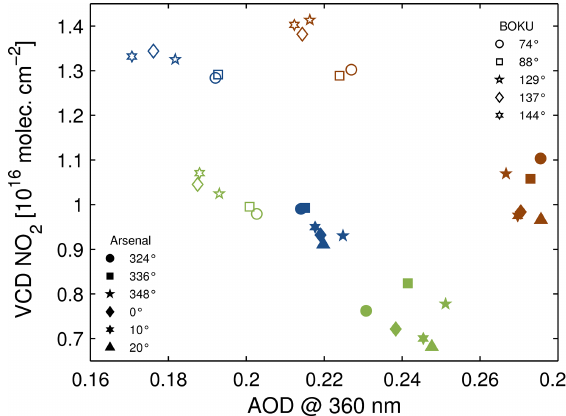
Figure 12. Spatial variability of the BOREAS vertically integrated profiling products AOD and VCD NO 2 , illustrated for the seasons fall (brown), winter (blue), and spring (green) as well as for the different azimuth angles of the two MAX-DOAS instruments. The symbols indicate azimuthal viewing directions of the BOKU and Arsenal MAX-DOAS instruments (see also Fig.